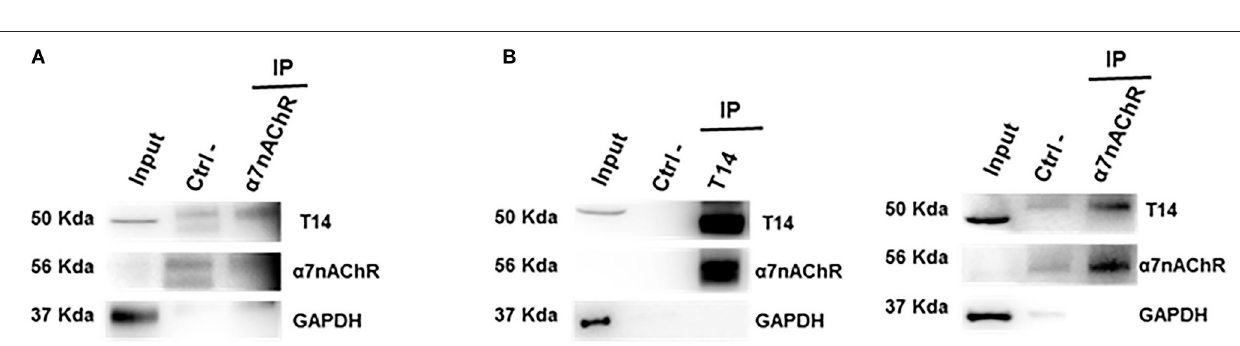
FIGURE 2 | T14 and α 7-nAChR directly interact. (A) Western blot analysis on immunoprecipitated lysate from ex-vivo brain sections (from seven animals) shows a protein-protein complex between the AChE bioactive peptide and the nicotinic receptor ( n = 2 independent pulldowns). (B) Immunolabeling on IP samples from whole brain homogenates confirms the interaction between the peptide and the receptor ( n = 4 independent experiments). In (A , B) Gapdh is used as loading control for the input and to identify any contamination in the immunoprecipitated